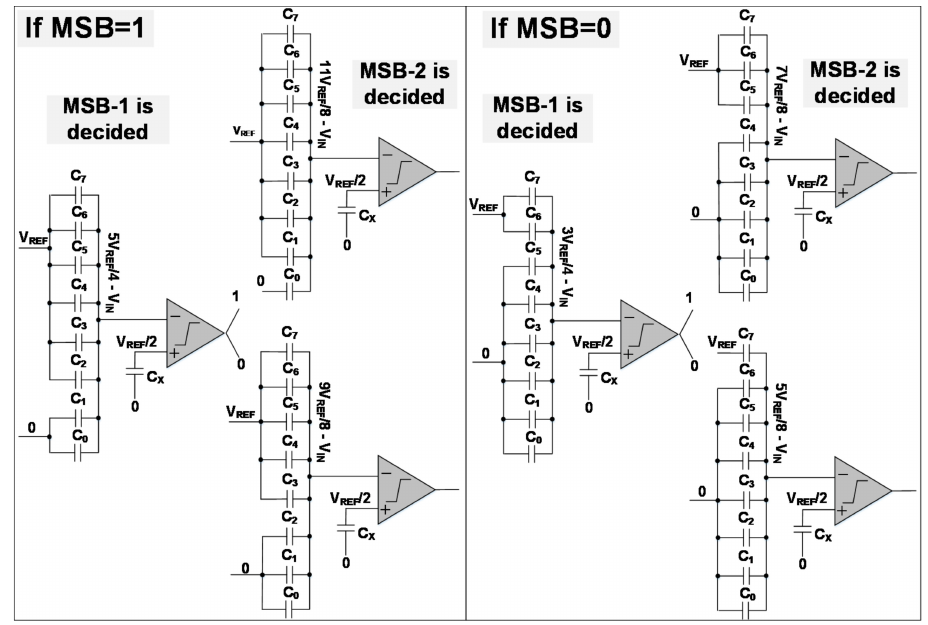
Figure 8. Binary code decision for MSB-1 and MSB-2 bits. MSB: most significant bit.